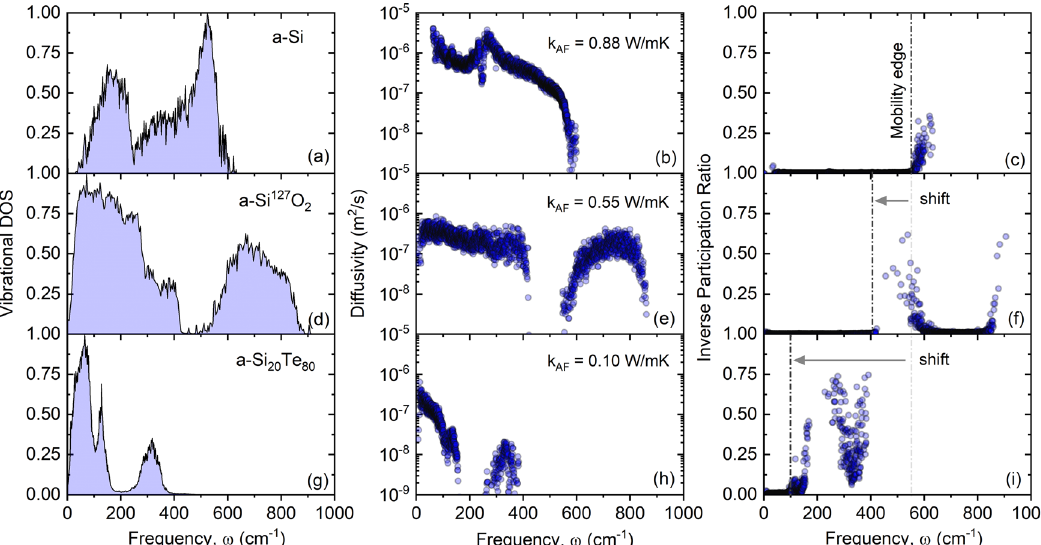
Fig. 3 Ab initio simulations results for vibrational modes in amorphous Si and its alloys. a , d , g Vibrational density of states DOS, b , e , h modes diffusivity, and c , f , i inverse participation ratio (IPR) as a function of frequency for amorphous silicon, a -Si, amorphous silicon heavy-oxide, a -Si 127 O 2 , and amorphous silicon telluride, a -Si 20 Te 80 , respectively. The corresponding thermal conductivity is given for each system. The shift in the mobility edge with respect to the a -Si is depicted by an